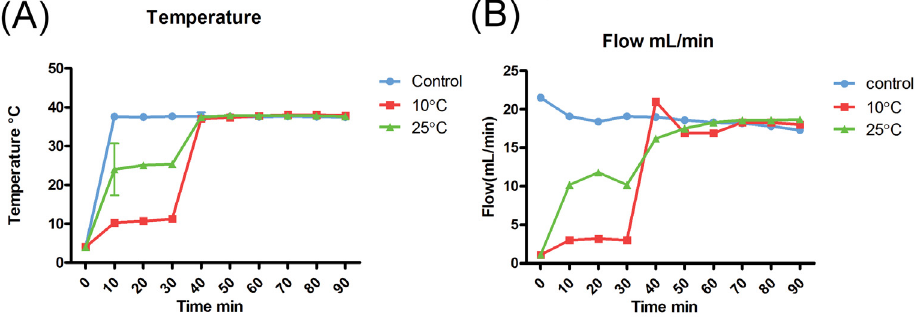
Fig 1. Panel A Thermal variation in the control and gradual rewarming groups during the perfusion period. Values are mean ± standard deviation. Panel B Flow variation in the control group and the rewarming groups during 90 minutes of perfusion. Values are mean ± standard